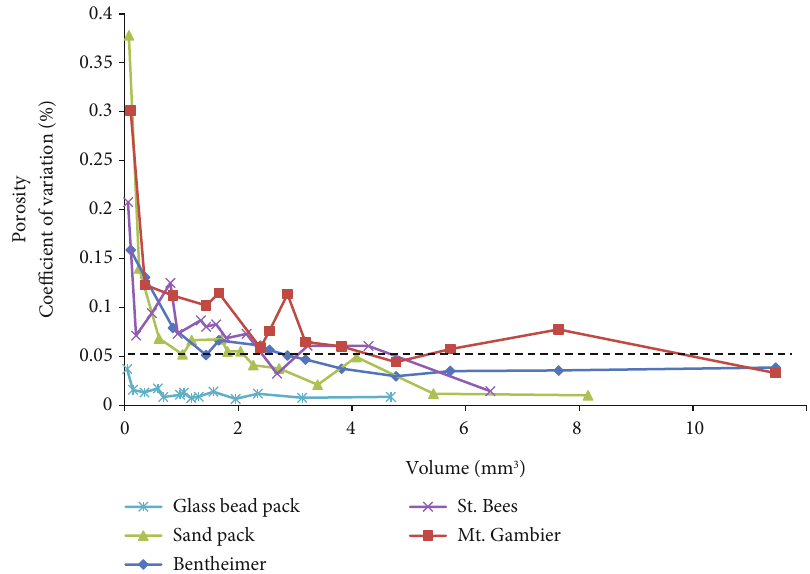
Figure 7: Coe ffi cient of variation of the fi ve samples plotted versus sample volume. The dashed horizontal black line is the 0.05 threshold. The power-law fi t for Mt. Gambier is indicated as a thin black line. Table 6: Fitting equations for the REV analysis using the CV approach. Porous